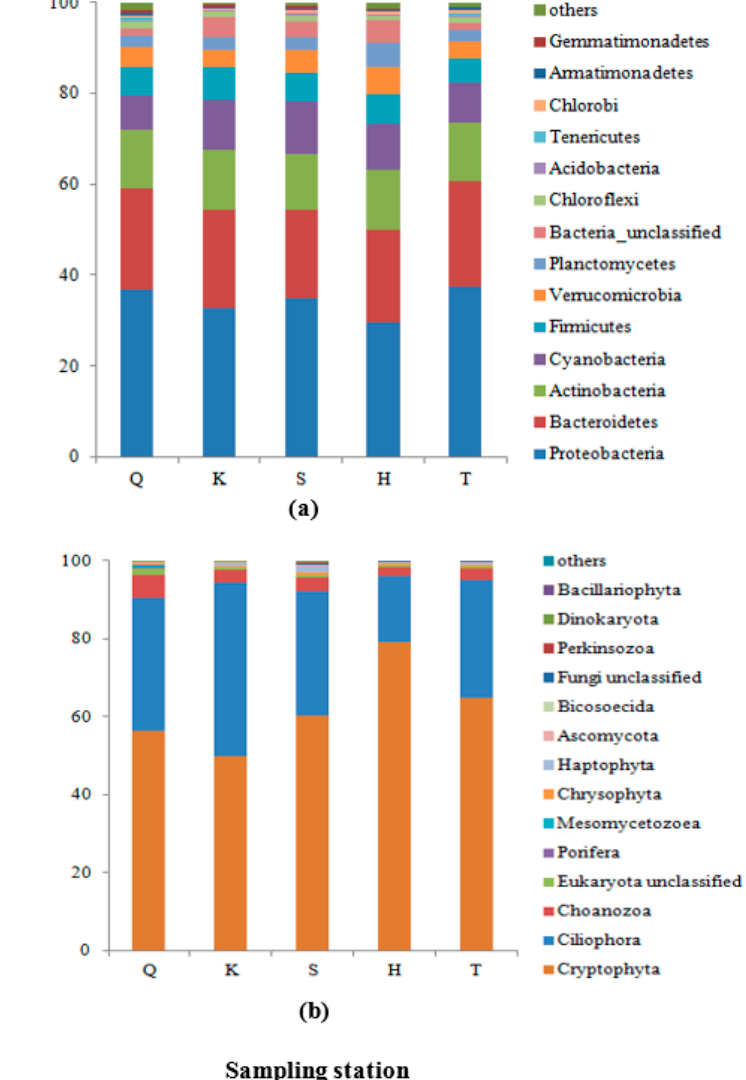
Figure 4. Relative abundance (%) of 16S ( a ) and 18S ( b ) assemblage structures at phylum levels in different stations. Only taxa with 0.05% abundance or more in the total dataset were identified in the legend. Station codes represented the first letter of their names: Q: Qushou, K: Kuxin, S: Songgan, H: Heijizuo, T: Taizishang.